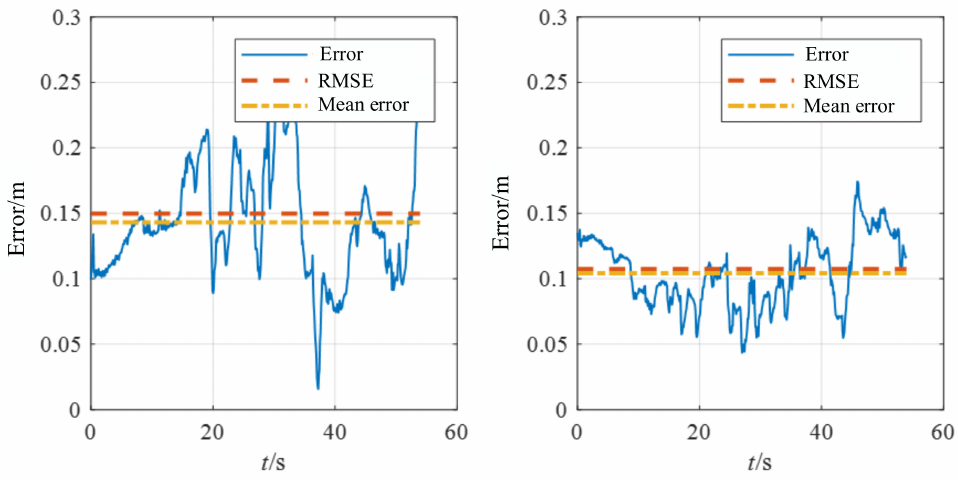
Figure 15. Comparison of the position error between VINS-Mono ( left ) and REVIO ( right